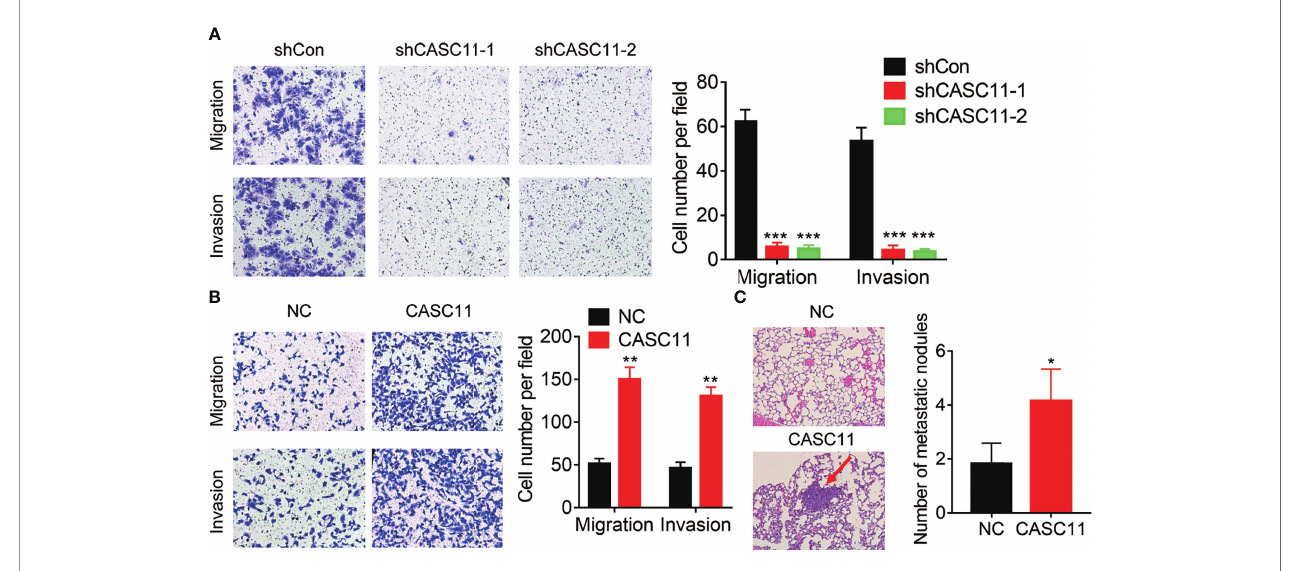
FIGURE 3 | CASC11 promotes HCC metastasis. (A) The transwell assay of CASC11 knockdown in Hep3B cells. (B) The transwell assay of CASC11 overexpression in Huh7 cells. (C) The control and CASC11 overexpressing Huh7 cells were injected into tail vein of nude mice (N=5). After 8 weeks, the pulmonary metastatic nodules were shown and counted. The red arrow indicates the metastatic nodules. Data are mean ± SD. *p < 0.05, **p < 0.01, ***p <